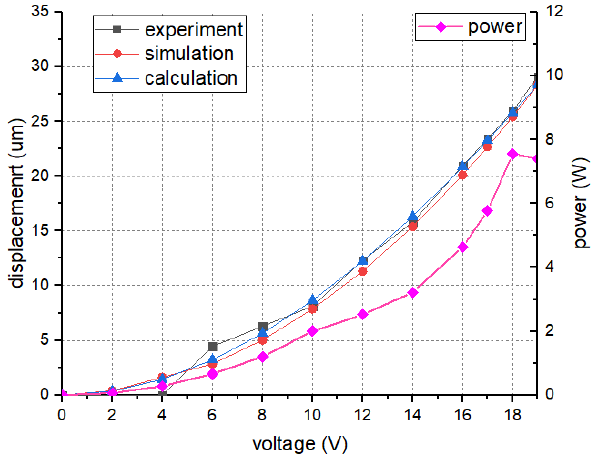
Figure 13. The test results of the electro‑thermal actuator.